Question: Condense the content of this figure into a single sentence.
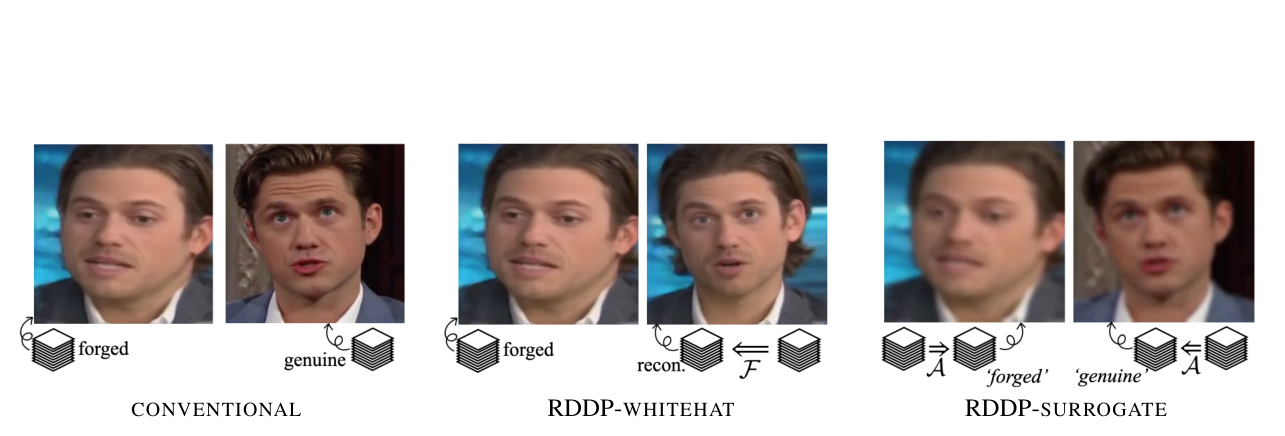
Answer: Comparison of the evaluation protocols. The CONVENTIONAL protocol directly contrasts forged and genuine data, allowing deepfake detectors to exploit the distribution shift between the forged and the genuine examples. In contrast, RDDP-WHITEHAT and RDDP-SURROGATE reduce this bias by 1) processing genuine examples through a white-hat deepfake function (F) to generate reconstructed examples (recon.), and 2) applying a surrogate function (A) to both forged and genuine videos, respectively. By removing the obvious disparities between genuine and deepfake videos, RDDP compels detectors to seek more robust detection cues, e.g., action sequences, as the above frame samples show that the differences in background and sharpness between forged and genuine in CONVENTIONAL is reduced in RDDP-WHITEHAT by changing the genuine and in RDDP-SURROGATE by transforming both sides uniformly.